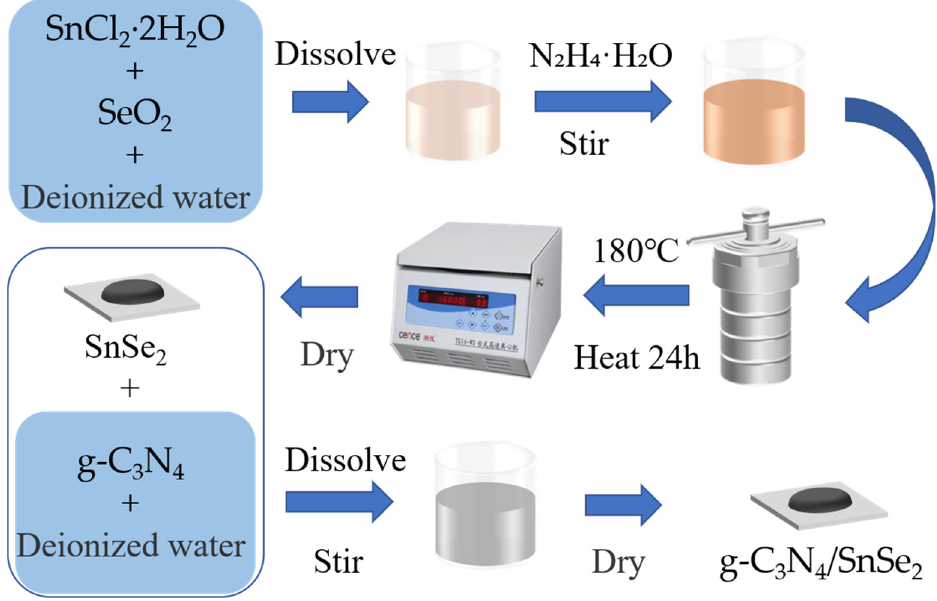
Figure 1. Synthesis process of g-C 3 N 4 /SnSe 2 nanomaterials.